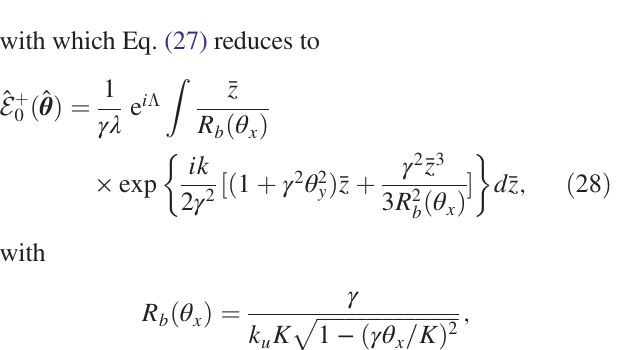
ffiffiffiffiffiffiffiffiffiffiffiffiffiffiffiffiffiffiffiffiffiffiffiffiffiffi 1 − ð γθ